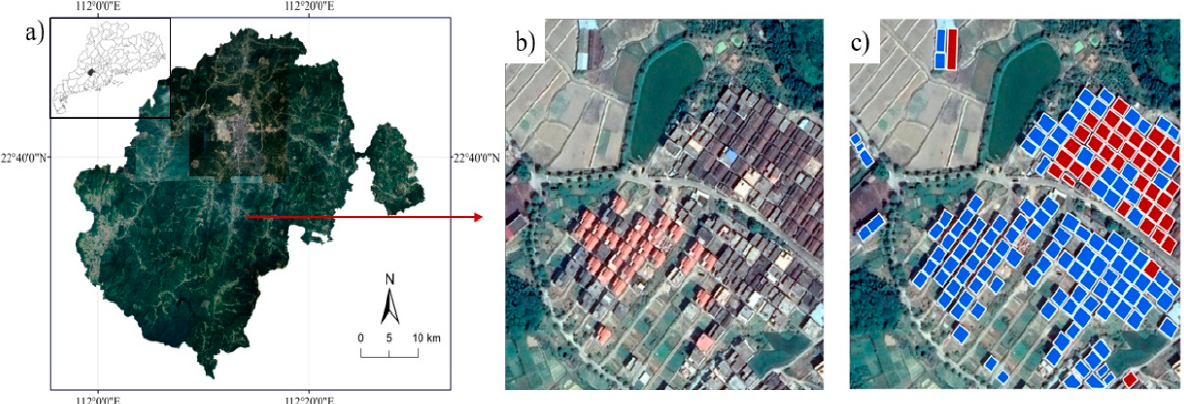
Figure 1. The study area. ( a ) The location of Xingxing in Guangdong Province, China, ( b ) a village of Xinxing ( c ) building labels of the same region in panel c (new and old buildings are masked in blue and red respectively).